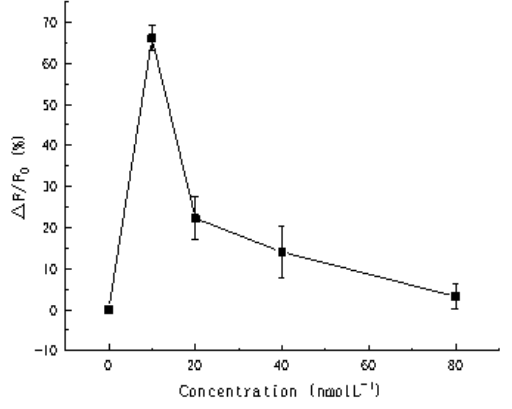
Figure 9. Fluorescence intensity ratio ( △ F/F 0 ) at an emission wavelength of 520nm in the presence of different concentrations of substrate.